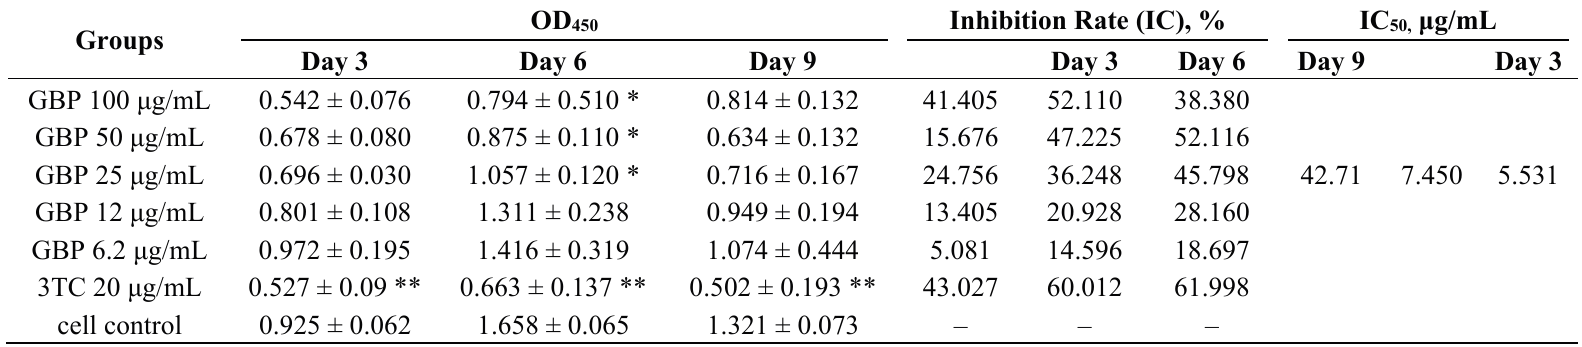
Table 3. Inhibitory effect of GBP on HBsAg secreted by HepG 2215 cells ( χ ± s, n = 4). Groups